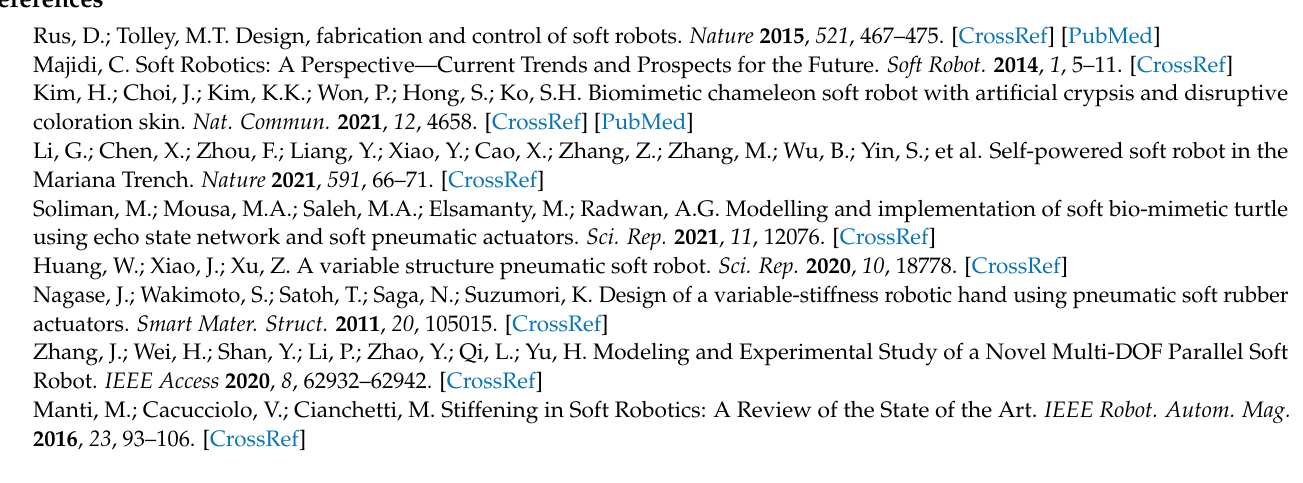
Figure S15: Applied force versus deflection curves of kraft rope at 0 kPa, Figure S16: Spider plot with three different jamming structures, Figure S17: Bending stiffness experiments of single wire jamming structure, Figure S18: Applied force versus deflection curves for a wire jamming structure, Movie S1: Demonstration of experiment platforms, stiffness experiments, grasping process and soft